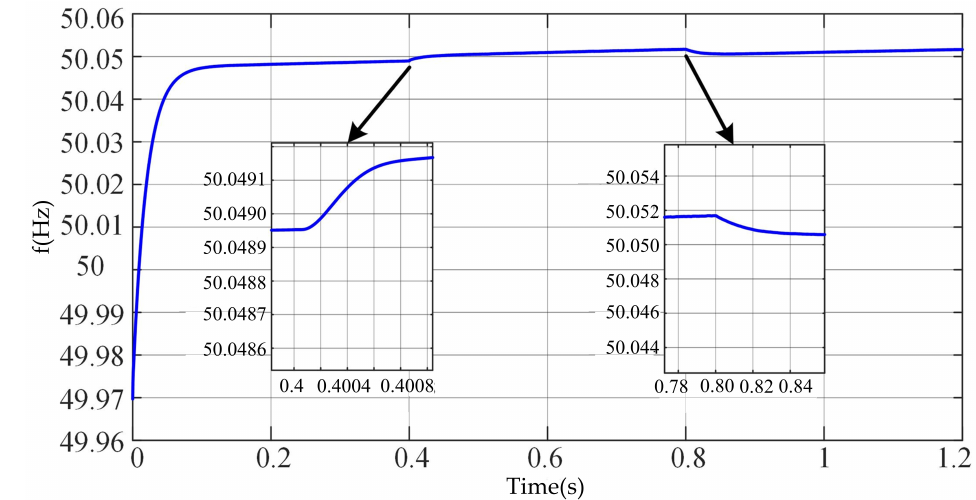
Figure 16. System frequency response result during the transition